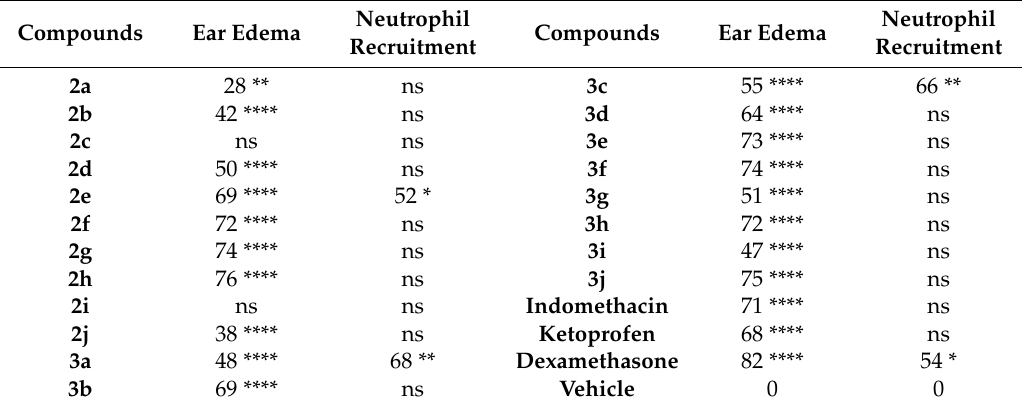
Table 3. Inhibition of ear edema and on neutrophil recruitment (%) by the control groups and synthesized